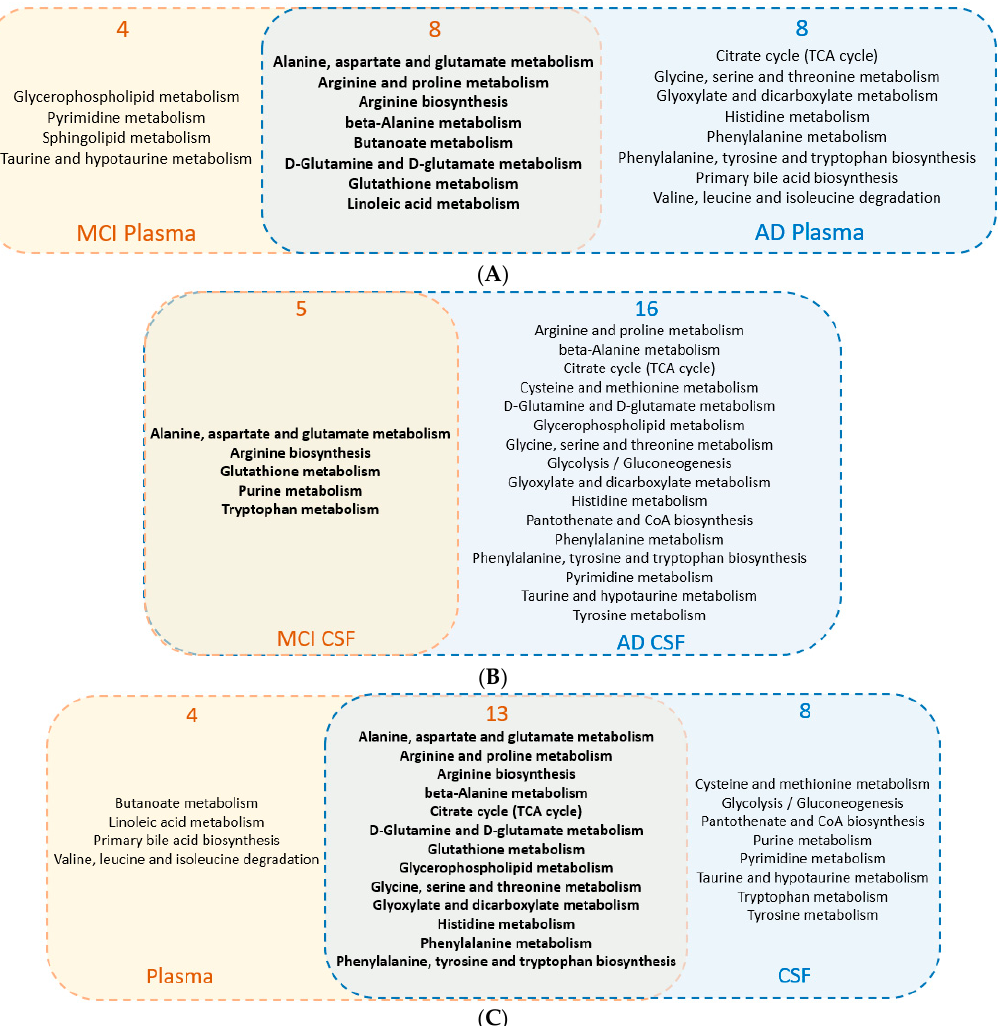
Figure 1. Metabolic pathway analysis in biological samples (CSF, brain, and plasma) of 43 human